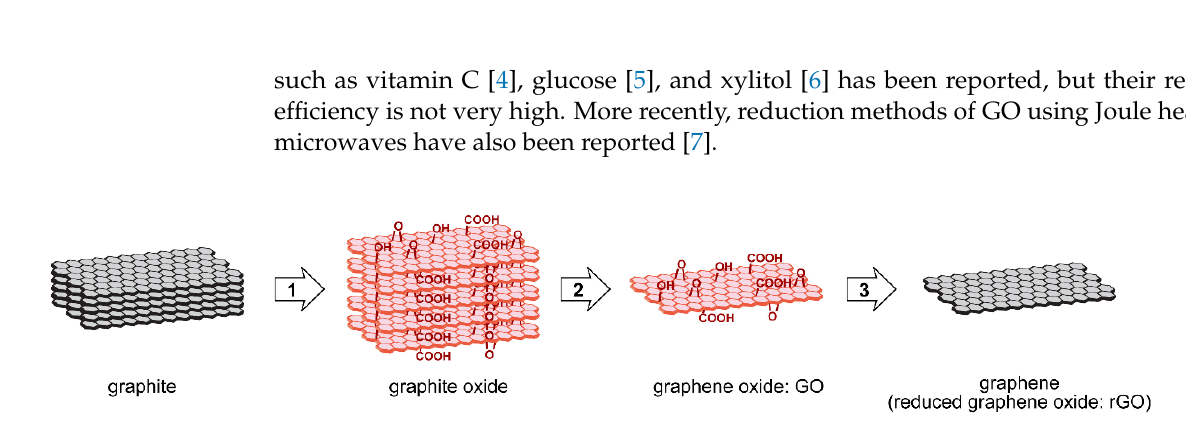
Figure 1. Synthetic route of graphene (reduced graphene oxide) through graphene oxide from graphite ( 1 : oxidation, 2 : exfoliation, 3 : reduction).